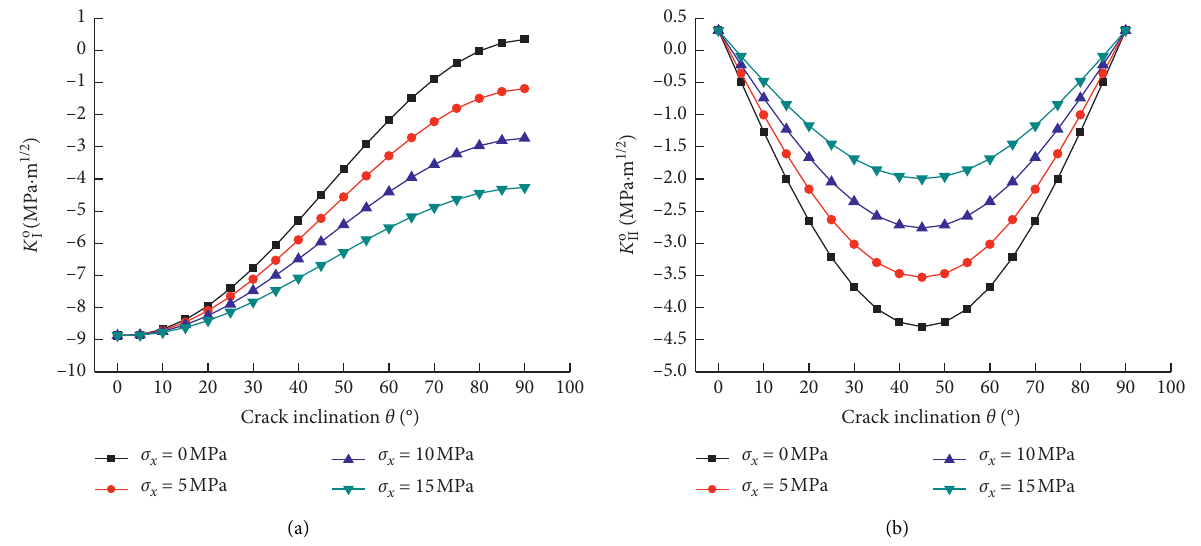
Figure 8: Relationship between crack inclination and stress intensity factor at different lateral pressures of open crack ( P (a) Mode I. (b) Mode II.